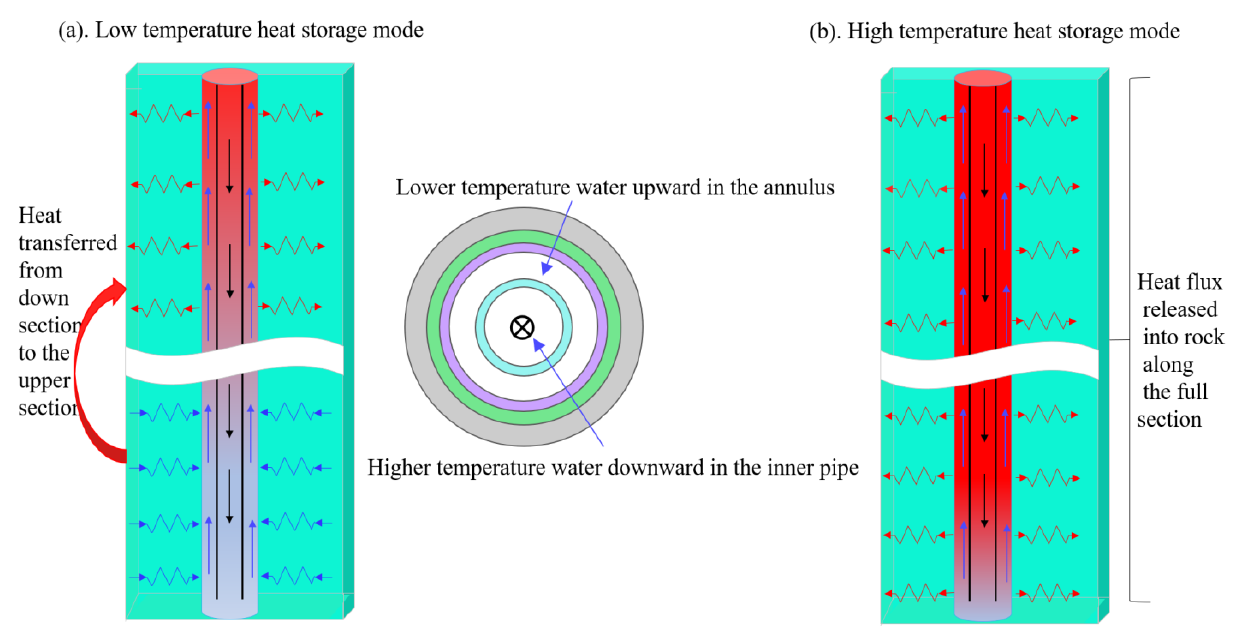
Figure 7. Comparison of low temperature and high temperature heat storage for the deep BTES system.